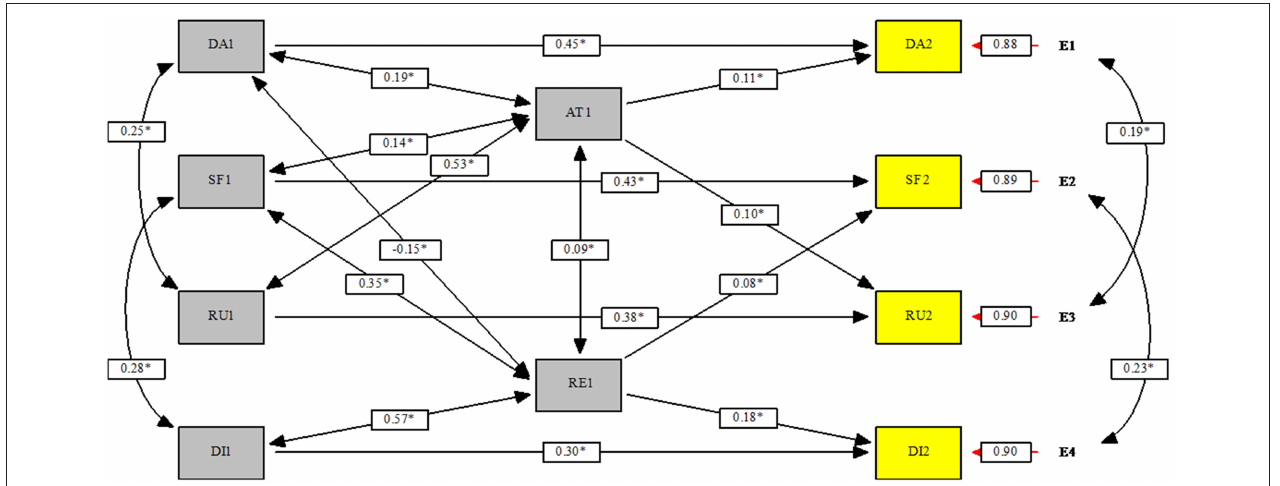
FIGURE 1 | Path analysis of responses of the relationships between responses to positive and negative affects in Times 1 and 2 and trait emotional intelligence dimensions in Time 1. AT, Trait Emotional Attention; RE, Trait Emotional Repair; SF, Self-focused Positive Rumination; DA, Dampening; RU,Depressive Rumination; DI, Distraction; 1, Time 1; 2, Time